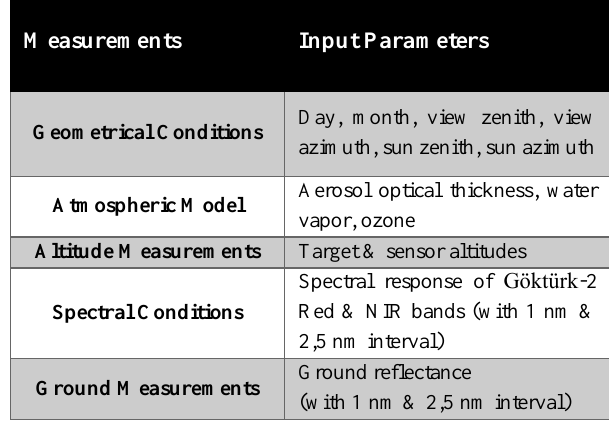
Table 1. 6S Input